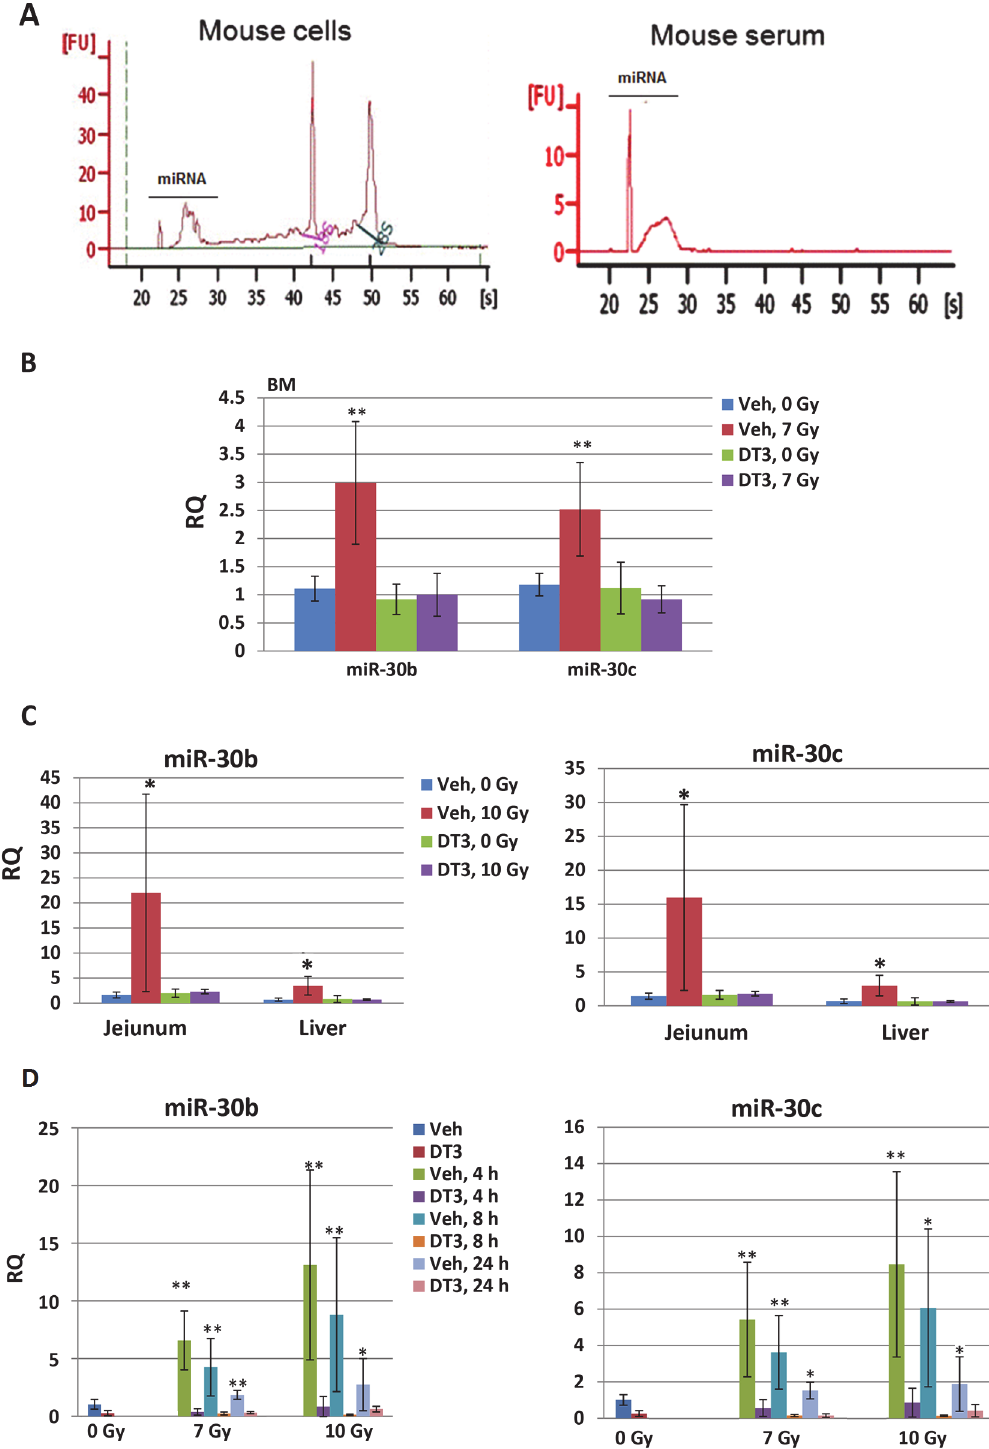
Fig 4. DT3 downregulated the expression and secretion of radiation-induced miR-30 in mouse tissues and serum. DT3 or vehicle was administrated 24 h before radiation and mouse tissues and serum were collected 1, 4, 8, or 24 h post-irradiation. (A) RNA and/or miRNA were extracted from mouse cells and serum using mirVana miRNA isolation kits following the manufacturer ’ s protocol. RNA quality was confirmed with an Agilent 2100 bioanalyzer (Agilent Technologies) with RNA 6000 Nano chips. DT3-treatment completely blocked the radiation-induced miR-30b and miR-30c expressions in mouse (B) BM cells after 7 Gy irradiation and in (C) jejunum and liver cells after 10 Gy irradiation, compared with vehicle-treated mice. (D) DT3-treatment suppressed miR-